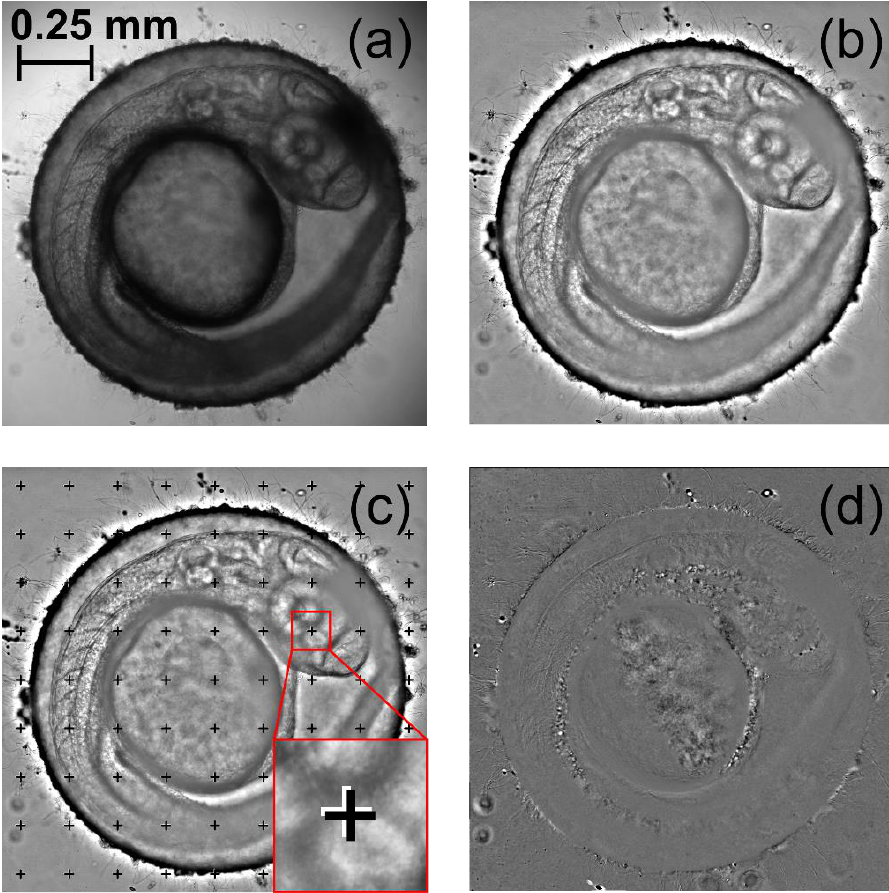
Figure 3. Stages of image pre-processing: ( a ) cropped image, ( b ) aligned image, ( c ) locally matched image and ( d ) blood flow image.